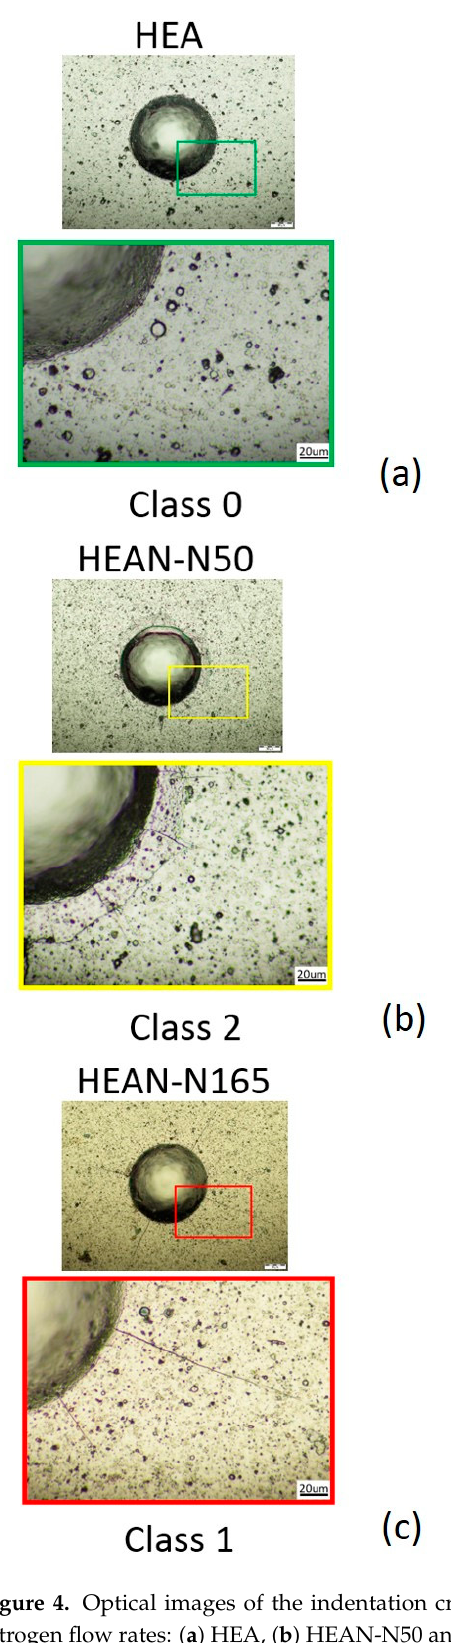
Figure 4. Optical images of the indentation crater of the CrVTiNbZr(N) coatings with different nitrogen flow rates: ( a ) HEA, ( b ) HEAN ‐ N50 and ( c ) HEAN ‐ N165.